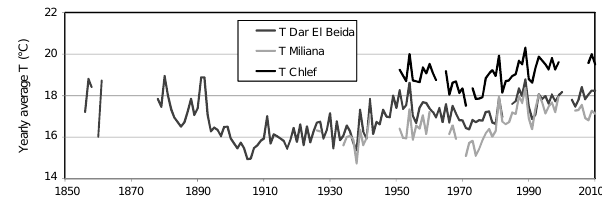
Figure 6. Interannual variations of mean yearly temperature (cal- culated from September to August monthly temperatures) at three stations in northern Algeria: Dar El Beida, Miliana and Chlef (from measurements of CRUTEM4 only, extrapolated values are not